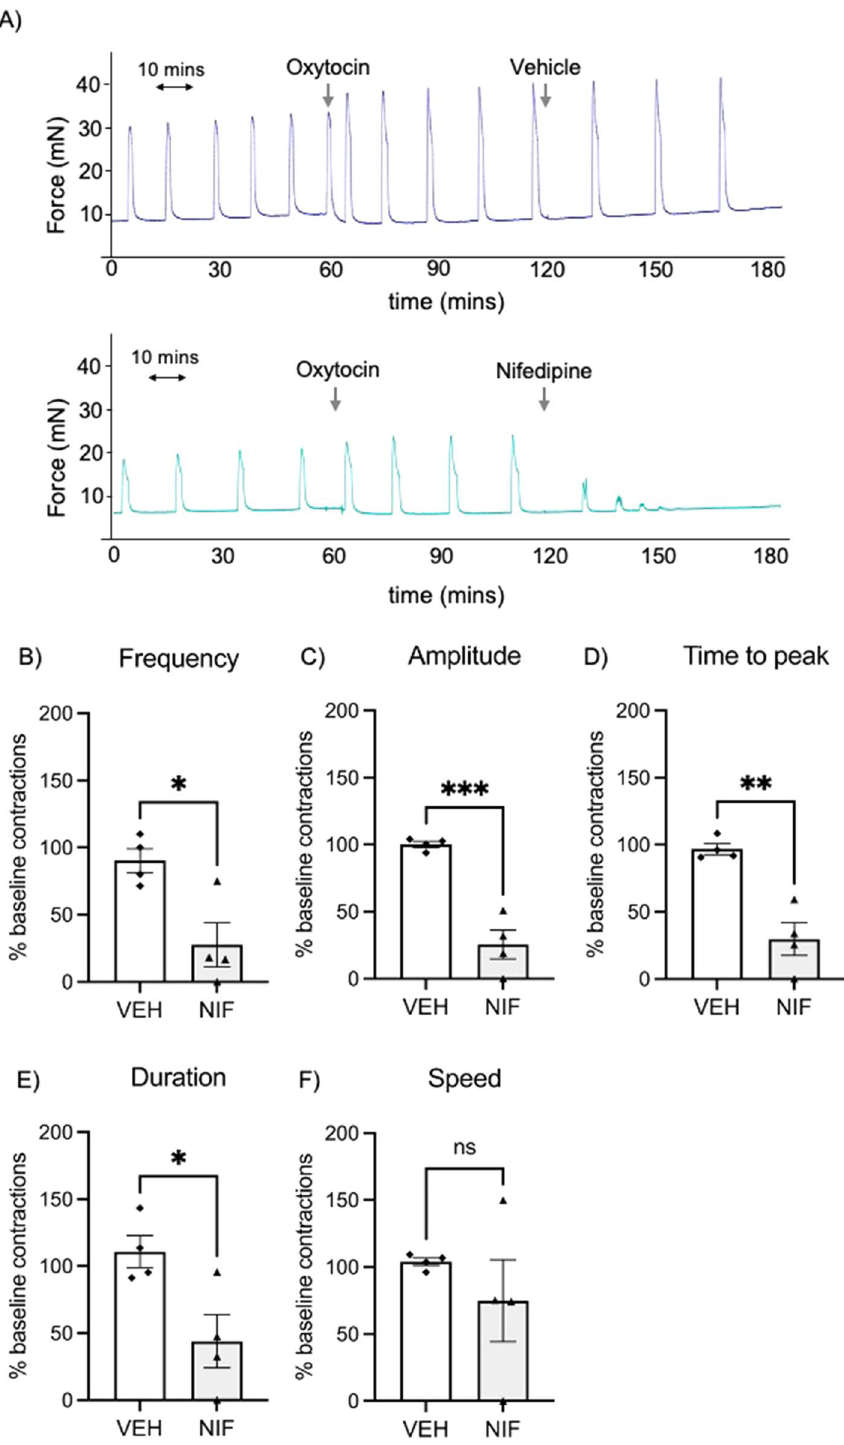
Figure 2. Myograph data showing anti-contractile effects of nifedipine (0.1 µM) on strips of human pregnant non-labouring myometrium ex vivo after incubation with oxytocin (1 nM). ( A ) Representative traces showing that vehicle control (VEH) does not affect frequency of established oxytocin-induced contractions, but nifedipine (NIF) significantly reduces the contraction frequency. The y-axis presents the measured force (millinewtons; mN). The entire initial 120 min equilibration period is not shown in these representative traces. ( B–F ) In the presence of oxytocin, nifedipine significantly reduces contraction frequency ( B ), amplitude ( C ), time to peak ( D ), and contraction duration ( E ) but not contraction speed ( F ) ( n = 4 patients). Each point represents the mean of duplicates. Data were assessed for statistical differences using t tests. The error bars represent SEM, * indicates P < 0.05, ** indicates P<0.01, *** indicates P<0.001, and ns denotes no statistical